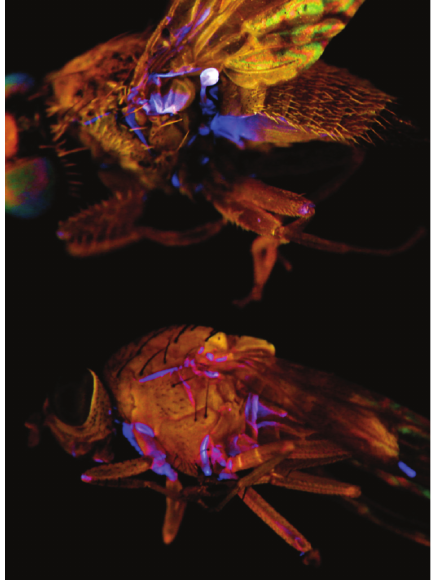
Figure 3: Blue fluorescence in UV light on ventrolateral (top) and dorsal (bottom, anterior at left) views of the thorax of the dragonfly Pachydiplax longipennis (Odonata: Libellulidae). Color intensity digitally increased.